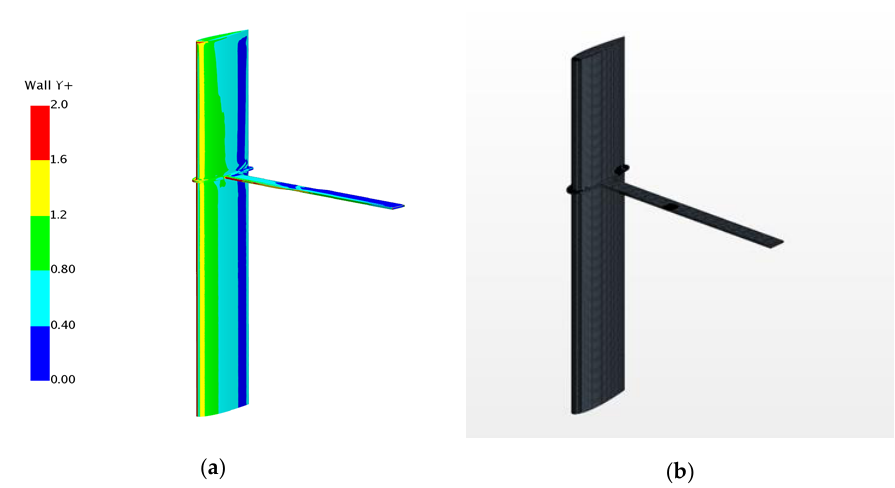
Figure 7. ( a ) Y+ distribution along the blade; ( b ) numerical mesh on the blade.